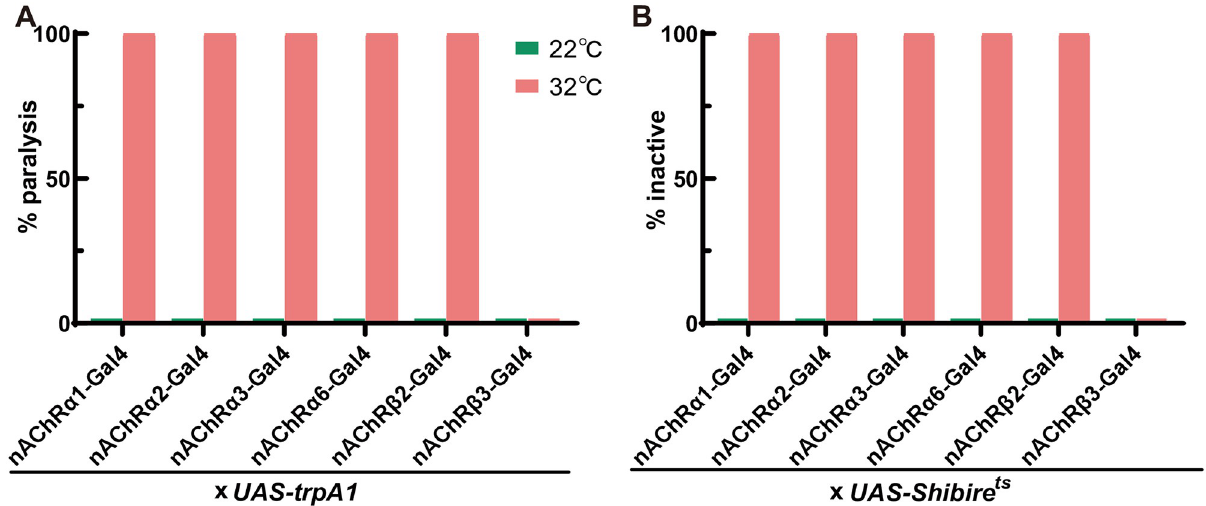
Fig 3. Effects of artificial neuronal activation and inhibition in various nAChR -expressing neurons. (A) Thermogenetic activation of five nAChR - expressing neurons using UAS-trpA1 -induced paralysis behavior. (B) Thermogenetic silencing of five nAChR -expressing neurons using UAS-Shibire ts decreased activity. n =